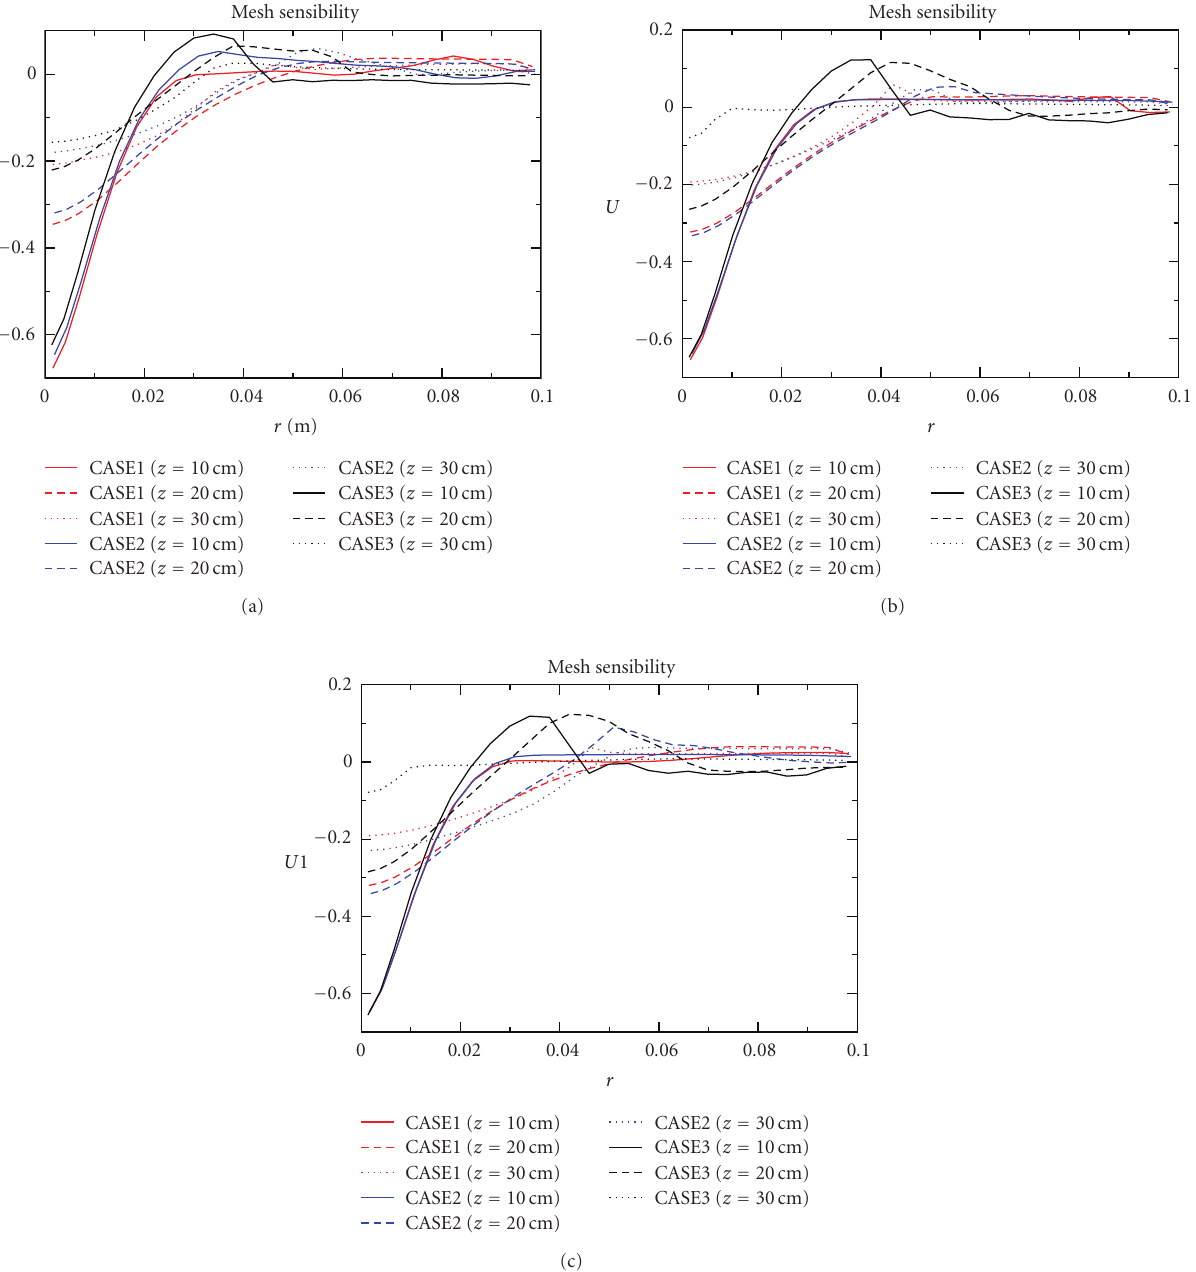
Figure 5: Mesh sensitivity study (CASE1 = finer mesh, CASE2 = mean mesh, CASE3 = coarser mesh): radial velocity profiles considering the modified k - ε model together with (a) separated phases model or (b) the Ishii’s correlation for C D , and (c) adding the nondrag forces (AM, L , TD)